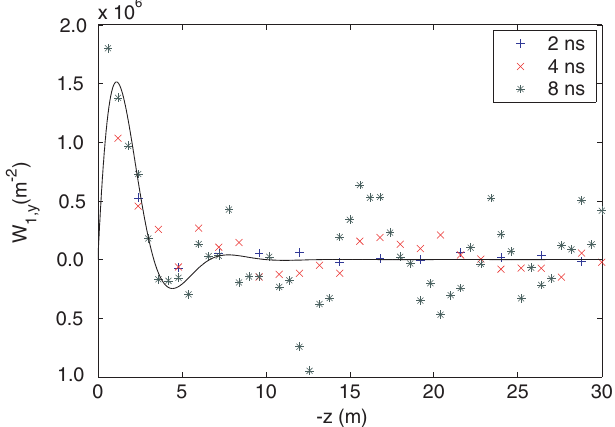
FIG. 5. (Color) Vertical wake field for 2, 4, and 8 ns spacing as a (cid:1) 2 mm . Primary electrons are function of z at KEKB, where y 0 produced at a photon-illuminated position, 30% of them are produced uniformly on the chamber surface, and secondary (cid:1) 1 : 0 . The solid electrons are produced with the rate, (cid:3) 2max line correspond to the wake field with the broadband resonator (cid:1) (cid:2) (cid:1) 0 : 7 cm 2 and (cid:10) (cid:1) 0 : 1 (cid:8) 10 10 m (cid:5) 1 model, (cid:2) x y e